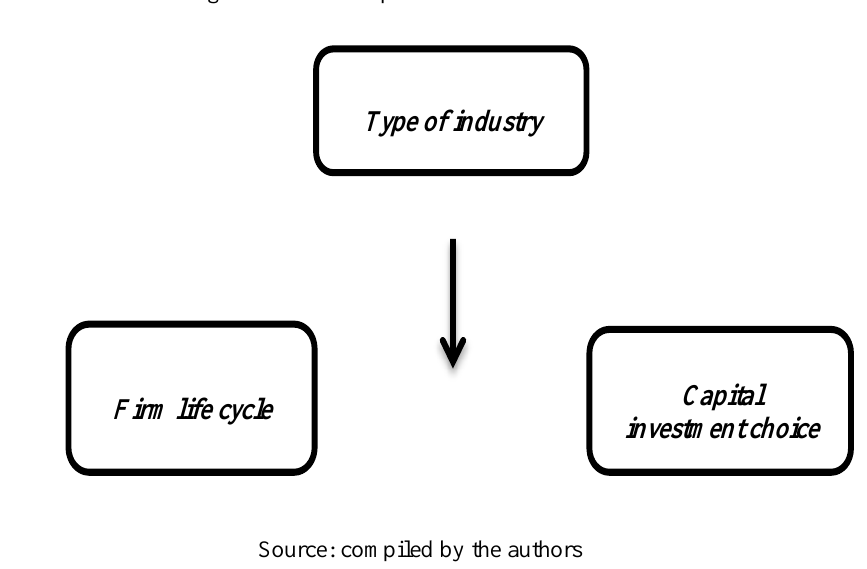
Figure1. The conceptual model of the research